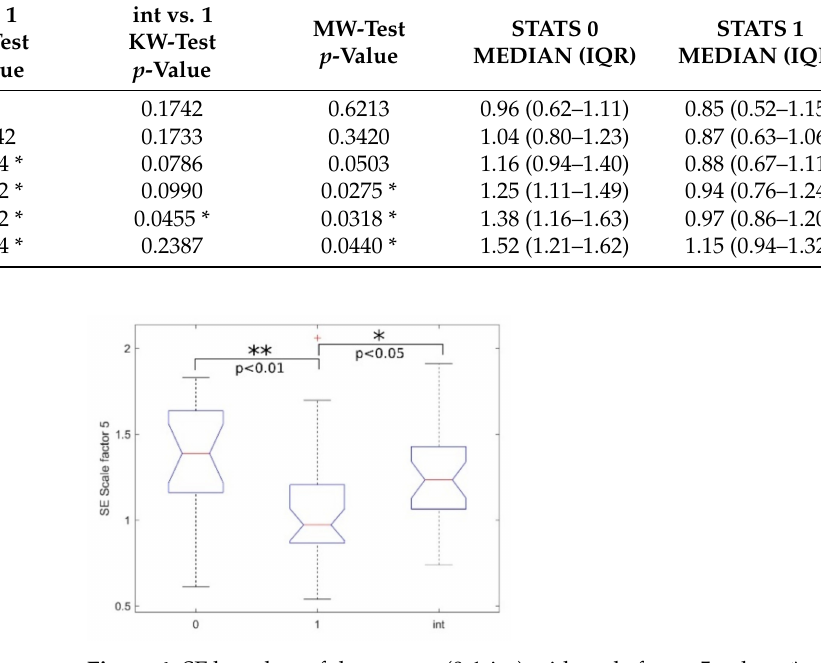
Figure 4. SE boxplots of the groups (0-1-int) with scale factor 5, where * and ** respectively denote statistically significant and highly statistically significant results obtained with the MCT test. Table 3 reports the statistical analysis performed using GSE with embedding dimen- sion m = 2 and a scale factor from 1 to 6 for multiscale analysis. At scale 1, the values are different from the MSE ones because the threshold factor r was set equal to 0.05 [28]. The statistics (median and IQR) for the three classes considered are included. In Figure 3c, the GSE trends as a function of the scale factor are